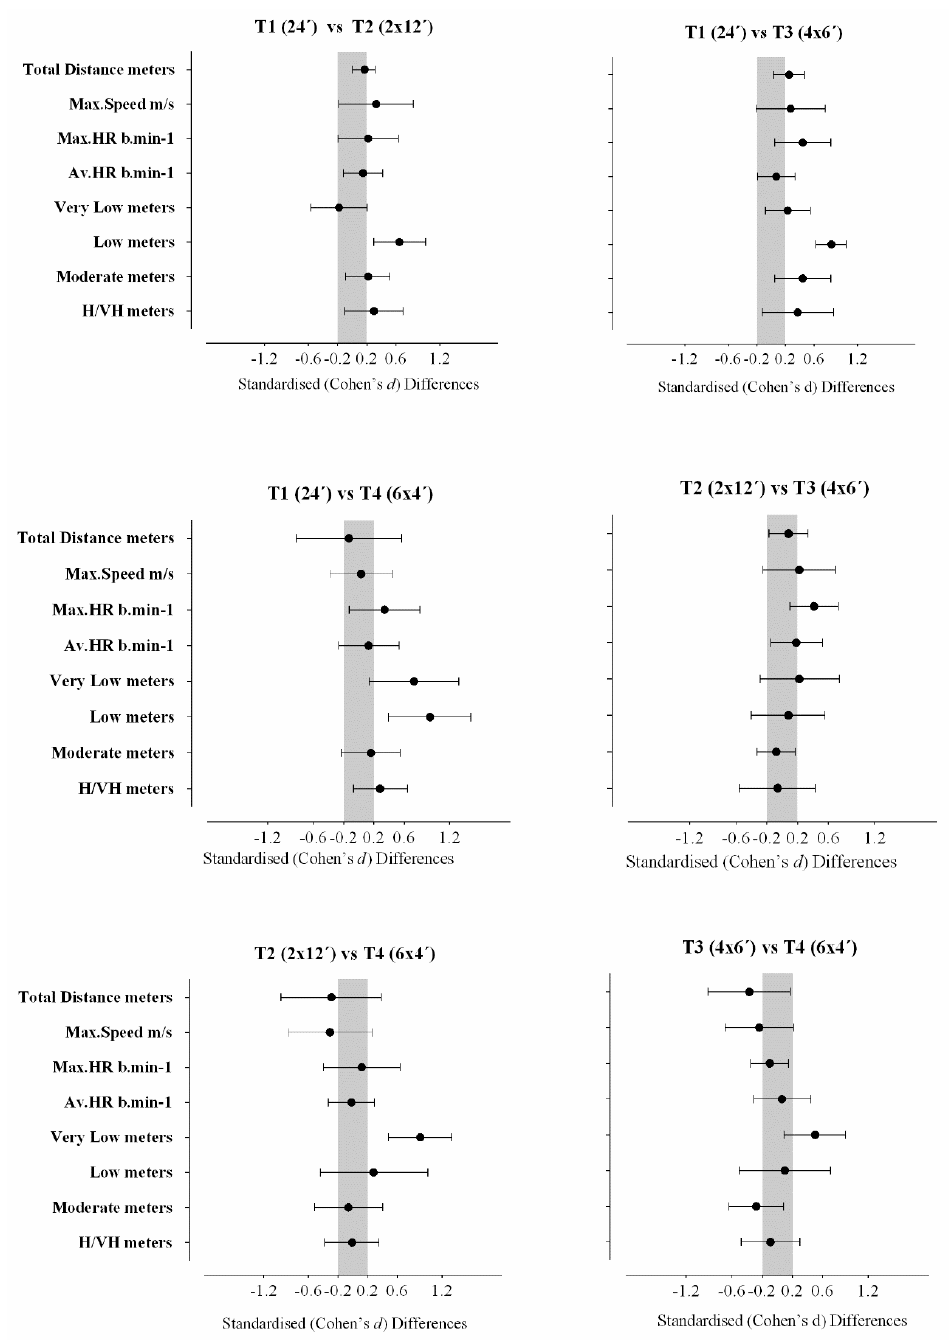
Figure 1. Standardized Cohen’s di ff erences for comparative results of the T1 vs. T2, T1 vs. T3, T1 vs. T4, T2 vs. T3, T2 vs. T4, and T3 vs. T4 SSGs. Error bars indicate uncertainty in true mean changes with 90% confidence intervals.